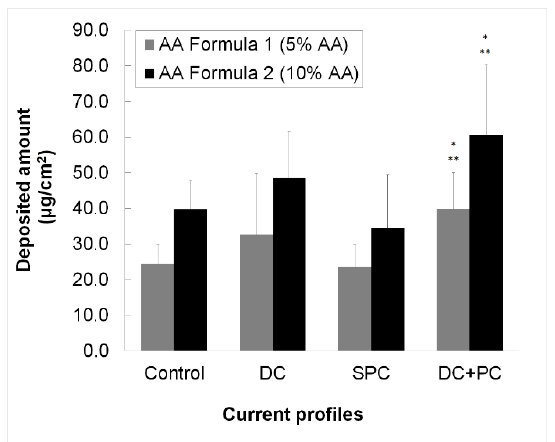
Figure 4. Deposited amount of AA obtained with AA Formula 1 (5%) and AA Formula 2 (10%) at each current profile (0.2 mA/cm 2 ) for 5 min iontophoresis ( n = 6). * Denotes statistically significant difference with respect to the corresponding control; ** denotes statistically significant difference with respect to the SPC current mode applied to the corresponding formula.